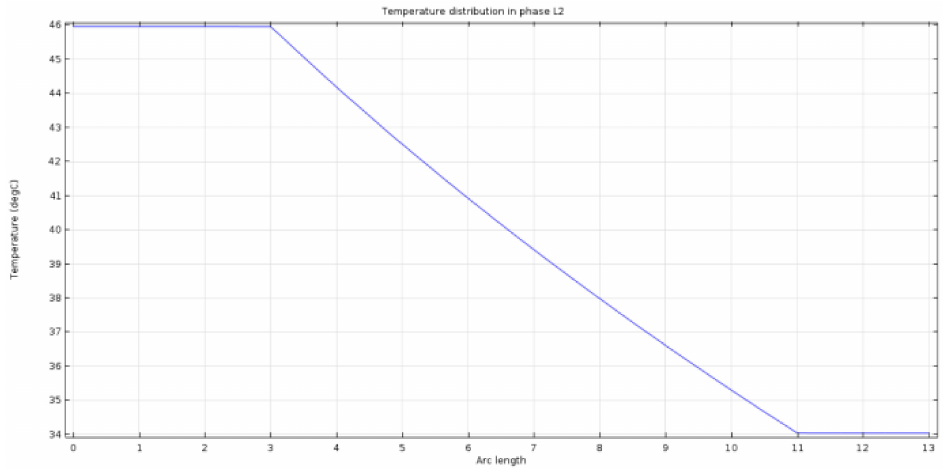
Figure 9. Temperature distribution along the segment CD shown in Figure